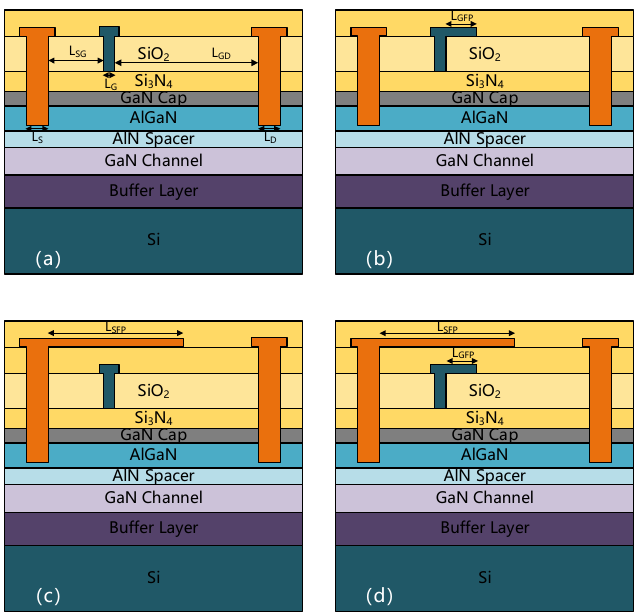
Figure 1. Schematic diagram of AlGaN/GaN HEMTs device structure and its field plate variation. ( a ) No FP. ( b ) G-FP. ( c ) S-FP. ( d ) SG-FP. ( a ) No FP. ( b ) G-FP. ( c ) S-FP. ( d )